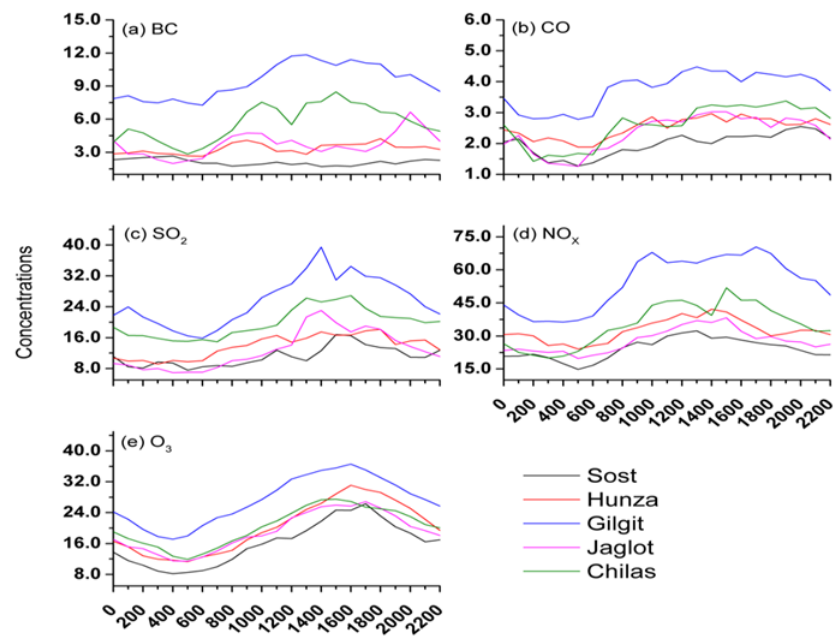
g/m 3 ), CO (mg/m 3 ), SO 2 , NO, NO 2 and O 3 in μ